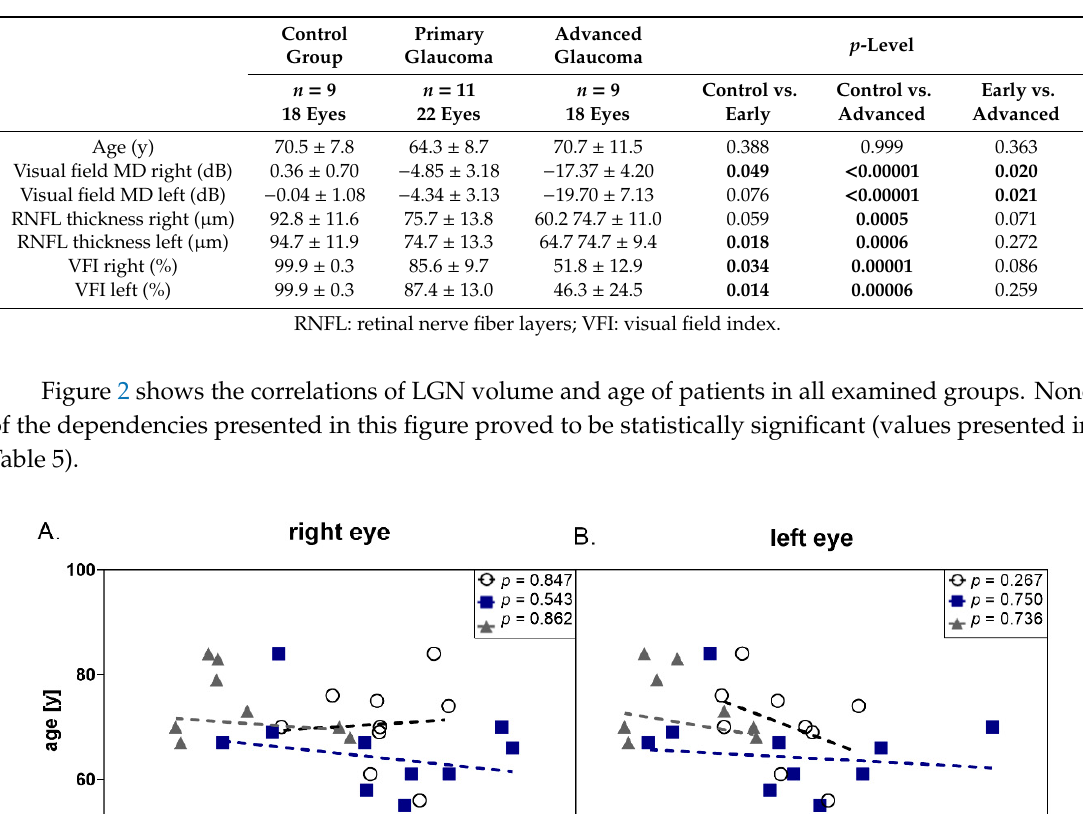
Table 2. Clinical characteristic of the examined groups (means ± SD)—one-way ANOVA statistical analysis (Kruskal–Wallis and Tukey’s test).